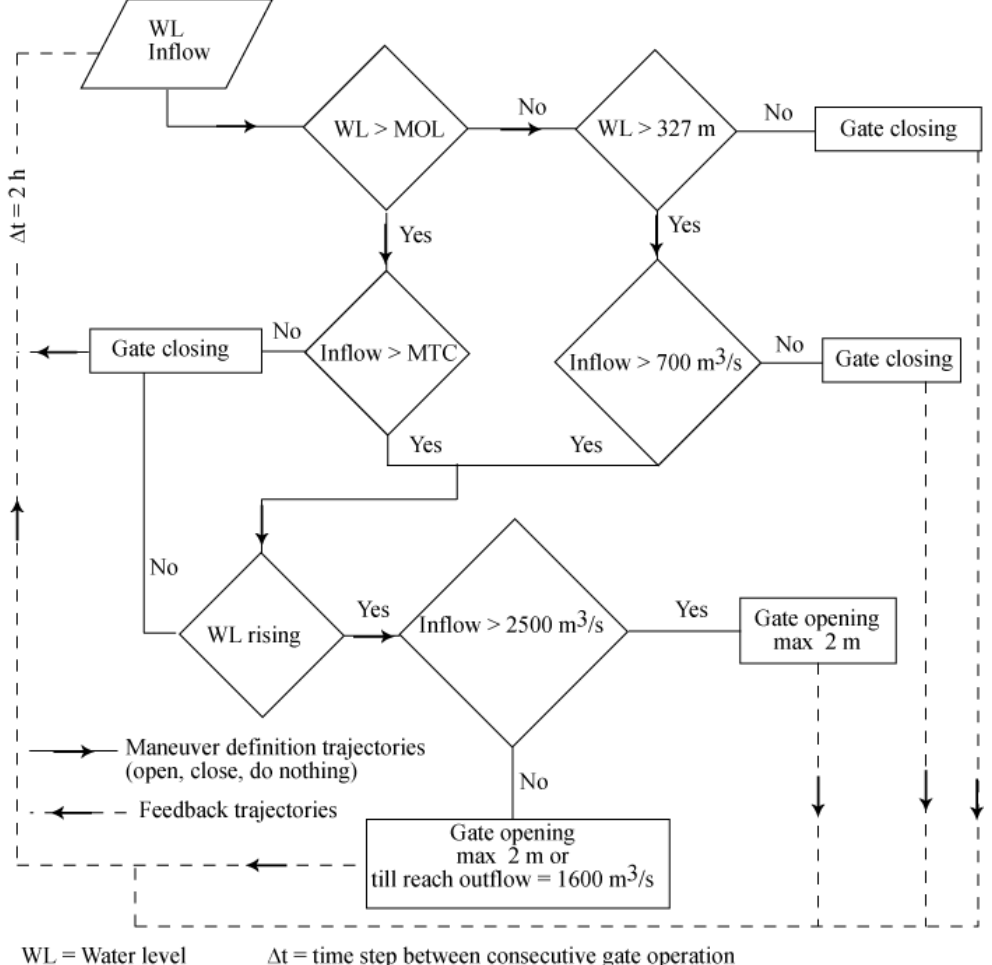
Figure 5. Flow chart schematizing the functioning of the S1 operating